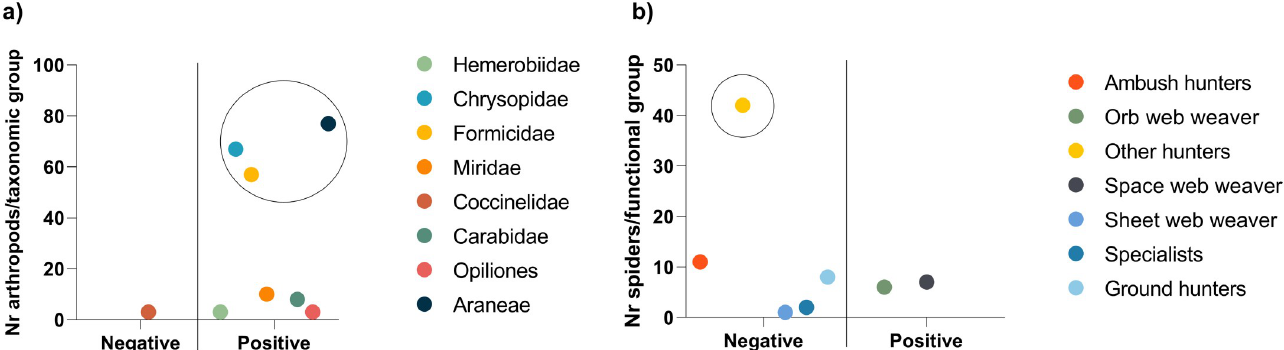
Fig 6. Molecular gut-content analysis of arthropods identified as potential SWD predators. a) PCR amplification results for the 8 families/orders identified, with the representation of the number of identified individuals from each family/order; b) PCR amplification results of the 7 spider functional groups, with the representation of the number of identified individuals from each functional group. Circled are the most relevant taxonomic groups (a) and functional group (b), with the highest number of identified individuals.